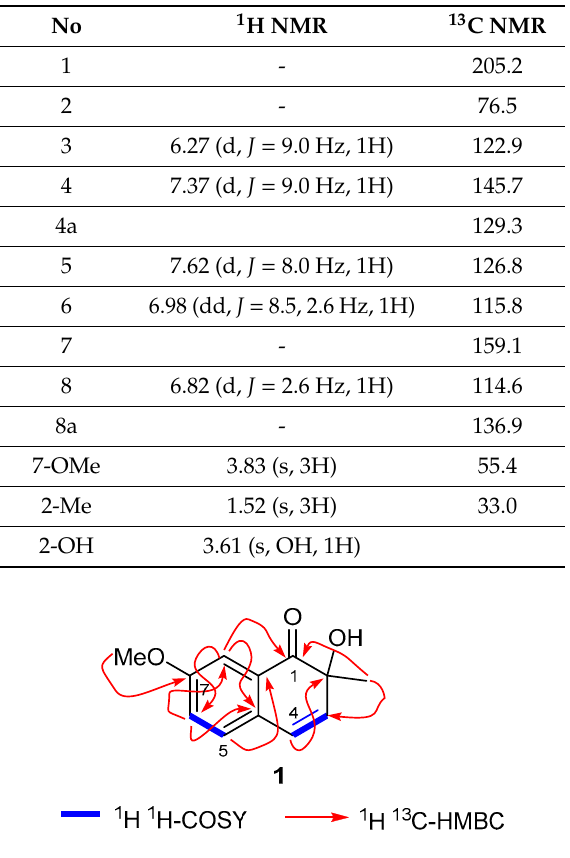
Figure 3. Key COSY and HMBC correlations of cichorin D ( 1 ).